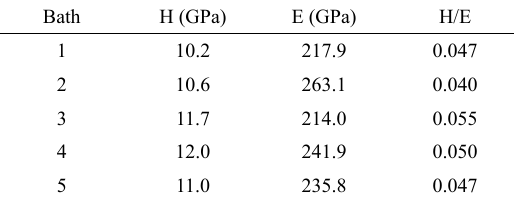
Table 5. Hardness (H), Young's modulus (E) and H/E ratio of the coatings produced in baths 1 to 5 after annealing for at 400 ºC 1 h.